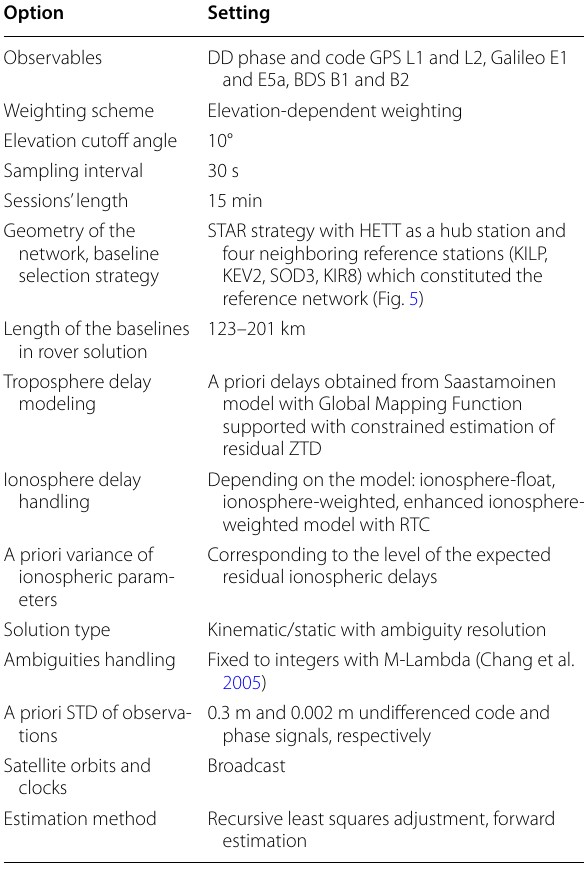
Table 2 Details of GNSS data processing for